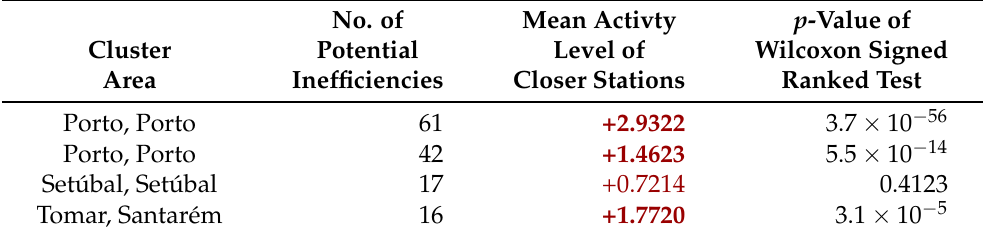
Figure 9. Visualizations of dense clusters of potential inefficiencies that occurred on certain days in 2019, showing the activity levels of the stations that are closer to the emergencies in question. Table 3. Potential inefficiencies on specific days. Actual dates are anonymized for privacy reasons. Bold values indicate significance at a 0.01 level. Red values indicate positive activity